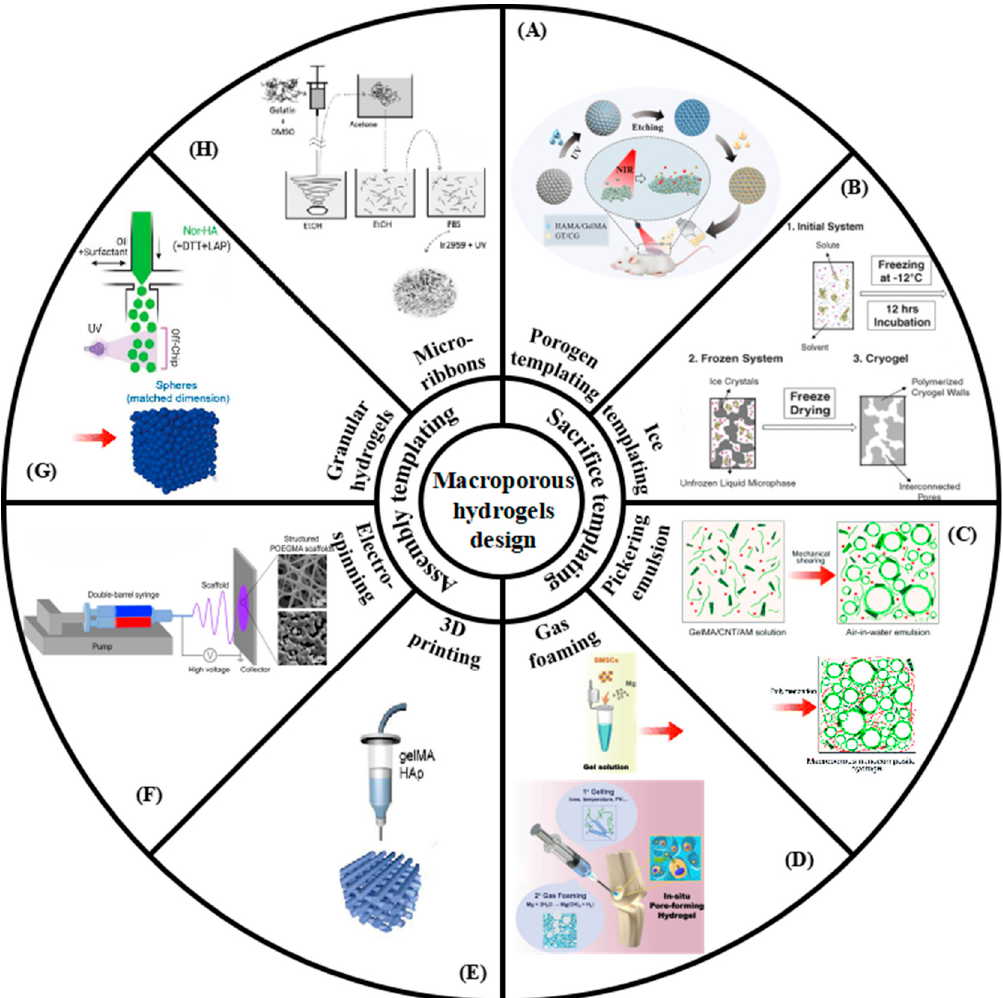
Figure 2. New progress in the preparation of macroporous hydrogels. ( A ) Porogen templating. Reprinted with permission from [171] , Copyright 2022, American Chemical Society. ( B ) Cryogel. Re-